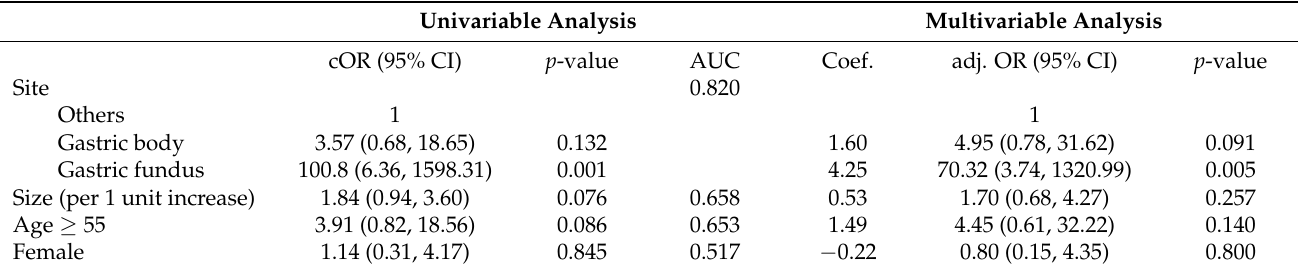
Table 4. Factors associated with LECS, according to univariable and multivariable analyses.